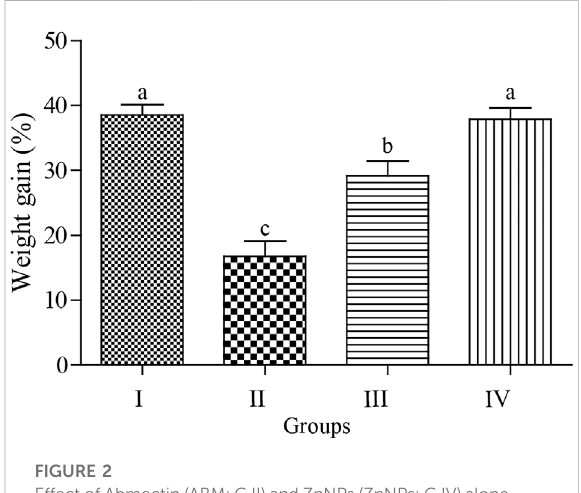
FIGURE 2 Effect of Abmectin (ABM; G II) and ZnNPs (ZnNPs; G IV) alone and together (G III) on for 3 weeks on rat ’ s body weight gain (%) compared with control (G I). The different letters represent